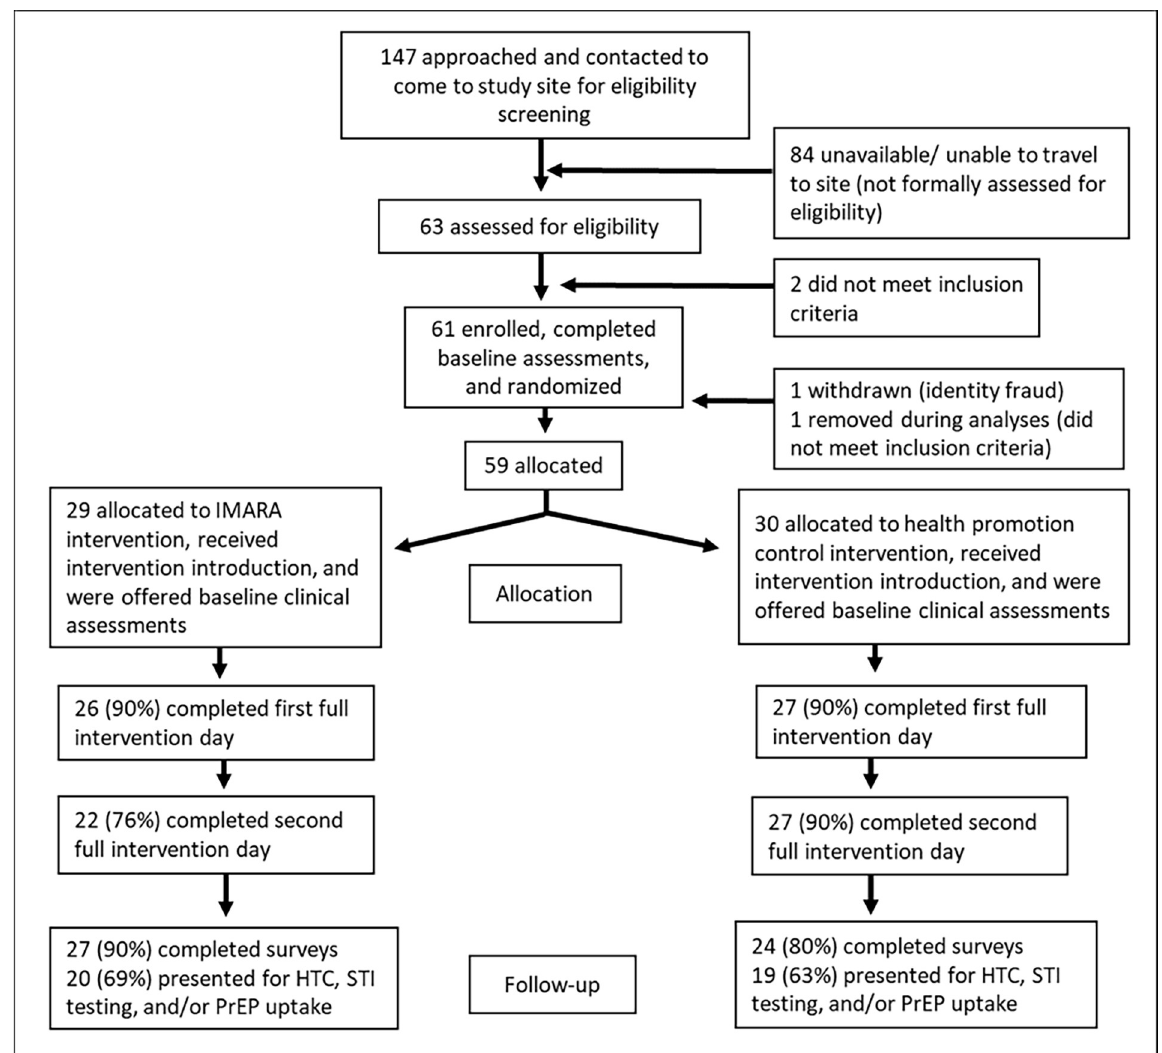
Fig 1. CONSORT diagram. Presents the flow of participants through the pilot study.